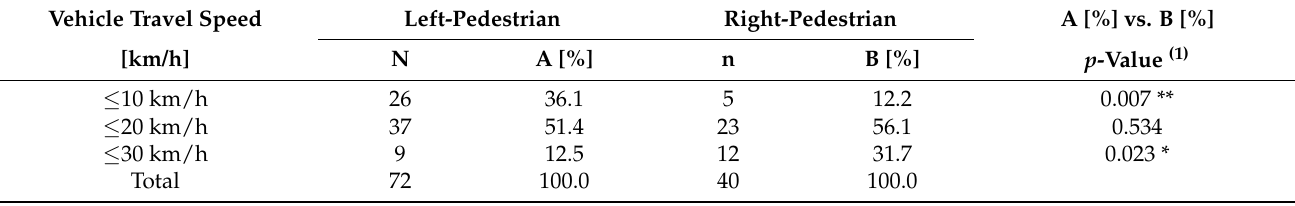
Table 3. Near-miss incidents according to range of vehicle travel speed in the presence of Left- Pedestrian and Right-Pedestrian.